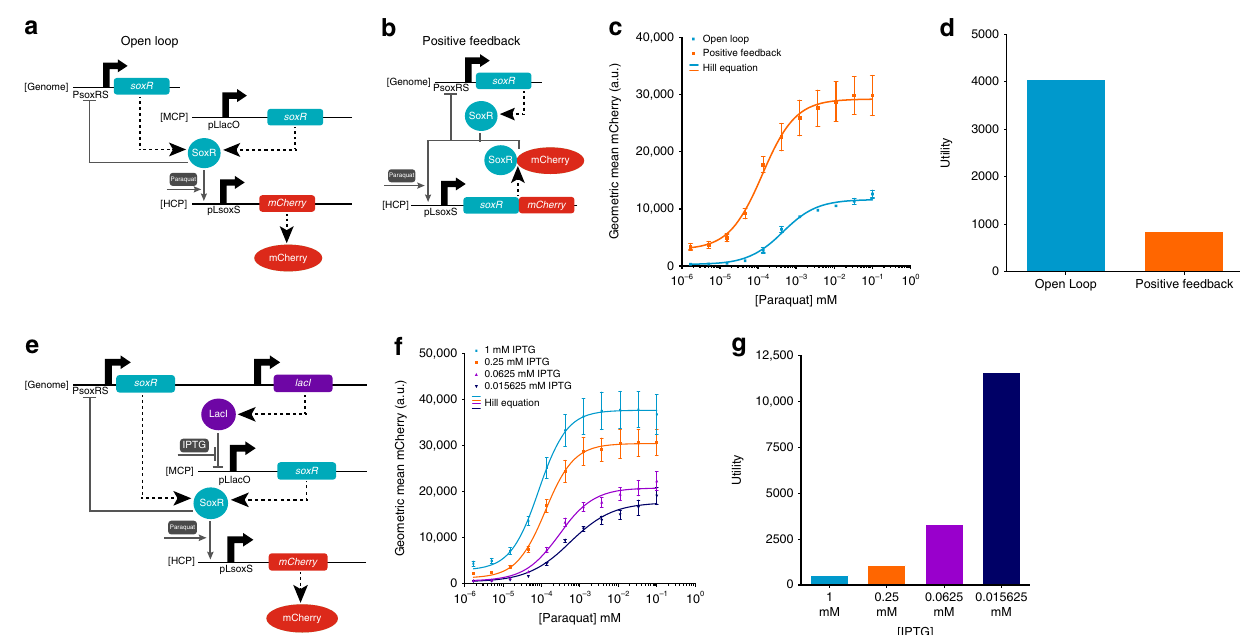
Fig. 2 Paraquat-sensing synthetic gene circuits. a OL paraquat-SoxR-pLsoxS circuit. SoxR is expressed from an unregulated constitutive pLlacO promoter on a MCP, and mCherry is expressed from the pLsoxS promoter on a HCP. b The PF paraquat-SoxR-pLsoxS circuit. A SoxR-mCherry fusion protein positively regulates its own expression from the pLsoxS promoter on a HCP. In both the OL and PF circuits, SoxR is also expressed from the genome and negatively regulates its own expression 69 . Dashed large arrows represent protein production and solid small gray arrows represent transcriptional regulation. c The empirical paraquat-mCherry transfer function for the paraquat-SoxR-pLsoxS OL (blue) and PF (orange) circuits. The lines are Hill equation fi ts to the raw data. d The utility for the OL and PF circuits calculated from the Hill functions in Fig. 2c. The OL circuit has a higher utility. e The paraquat- SoxR-pLsoxS OL circuit in E. coli MG1655Pro cells. MG1655Pro constitutively expresses the lacI repressor, which represses the pLlacO promoter and thus soxR expression from the MCP. IPTG induces expression from the pLlacO promoter in this context. f The empirical paraquat-mCherry transfer functions for the paraquat-SoxR-pLsoxS OL circuits at different IPTG concentrations in MG1655Pro. g The utility calculated from the Hill functions in Fig. 2f. The lowest concentration of IPTG yields the highest utility. The errors (s.e.m.) are derived from three biological replicates and fl ow cytometry experiments, each involving 30,000 events. Source data are provided as a Source Data fi